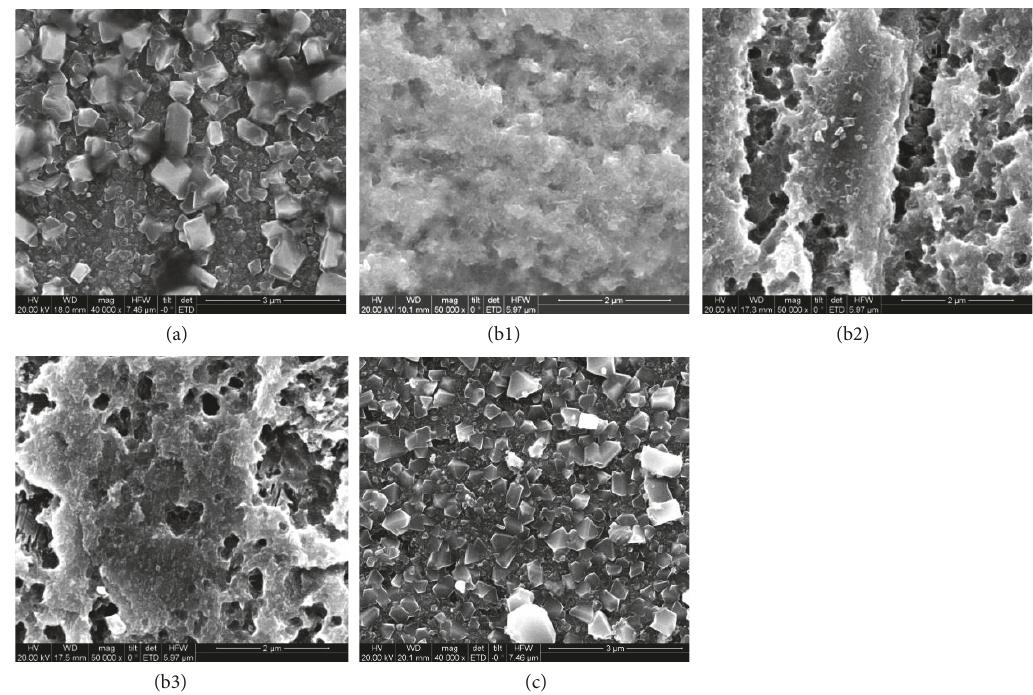
Figure 7: The micromorphology of (a) preoxidation 304L SS, ((b1) (b2) and (b3)) preoxidation 304L SS carrying out AP-N decontamination of 1 ∼ 3 cycles, respectively, and (c) reoxidation 304L SS carrying out AP-N decontamination of 3